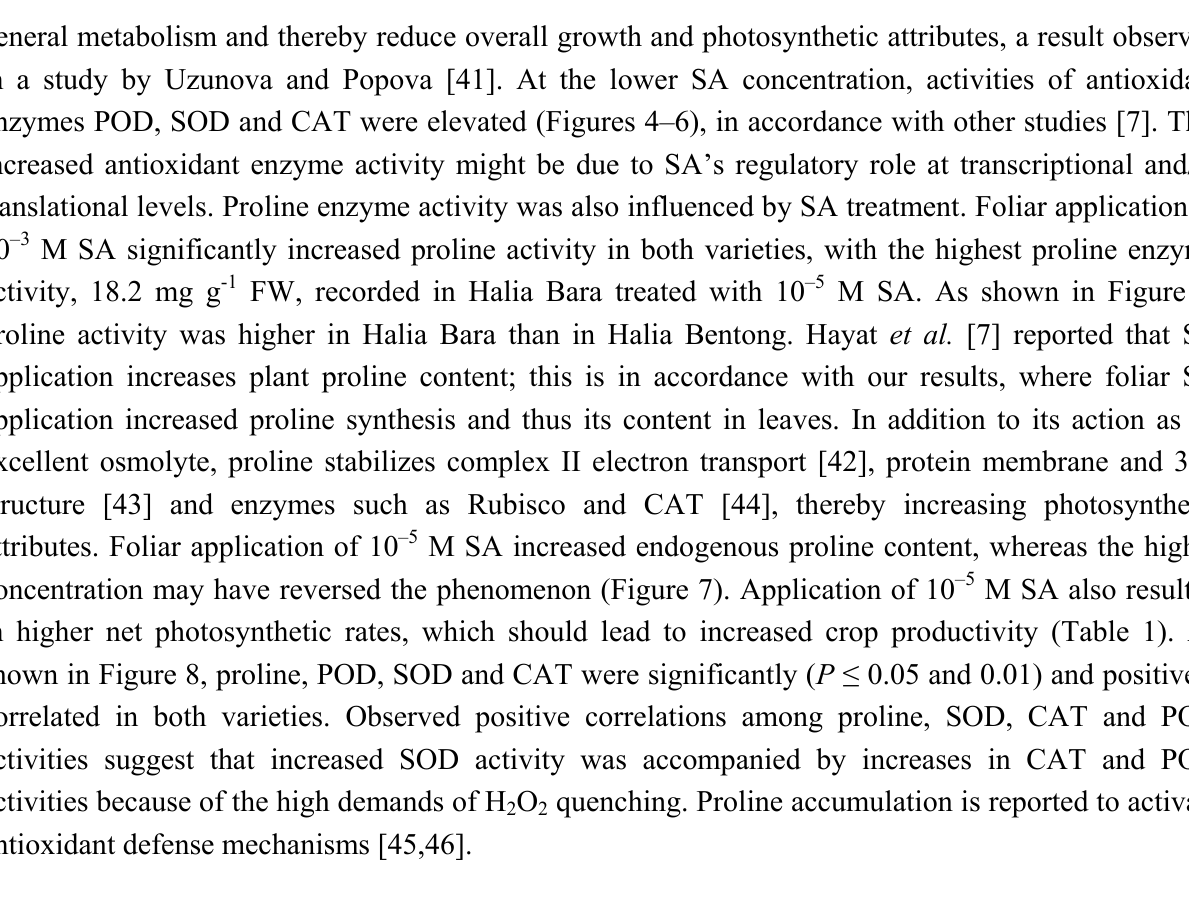
Figure 3. Gel image of peroxidase enzyme activity in Halia Bentong ( A ) and Halia Bara ( B ) treated with different concentrations of SA (SA0: control; SA1: 10 –3 M; SA2: 10 –5 M).